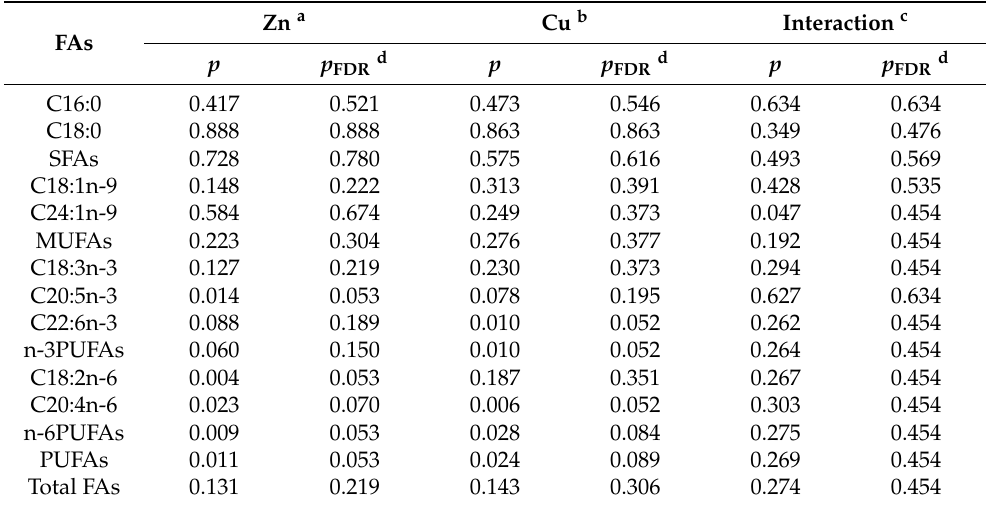
Table 4. The interactions of Zn and Cu in FA metabolism among children by general linear